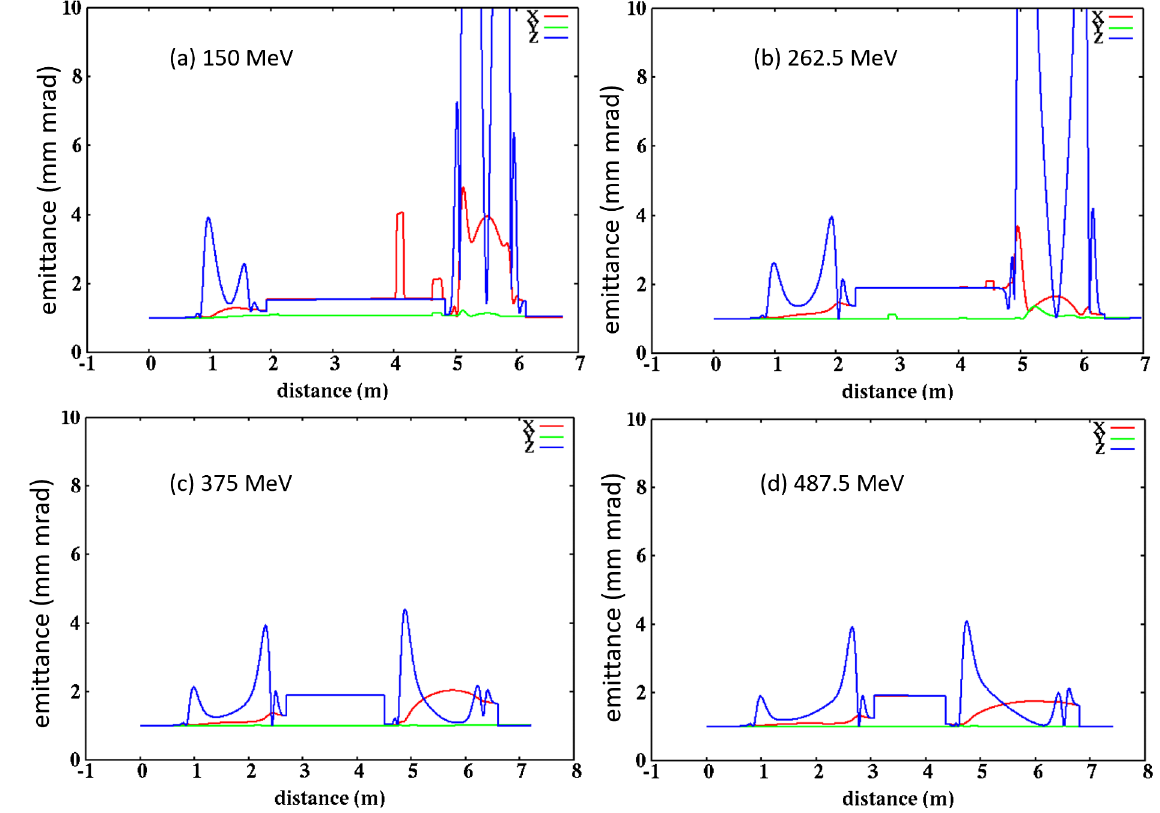
FIG. 8. Proton beam transverse and longitudinal RMS emittance evolution through the phase shifter with 150 MeV (top left), 262.5 MeV (top right), 375 MeV (bottom left), 487.5 MeV (bottom right) kinetic energy, initial Gaussian distribution, and 40 mA